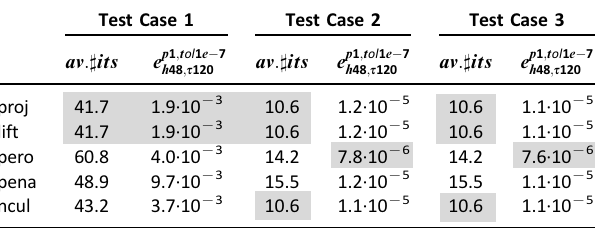
Table 3. Performance of GMRES within various formulations, see section GMRES performance . The averaged number of iterations per time-step av :] its and the approximation error for several methods and all three test cases for N h ¼ 48, N s ¼ 120, and linear elements ( cg ¼ 1 ) in the case that the resulting linear equations are solved using GMRES up to a relative residual of tol ¼ 10 (cid:3) 7 .